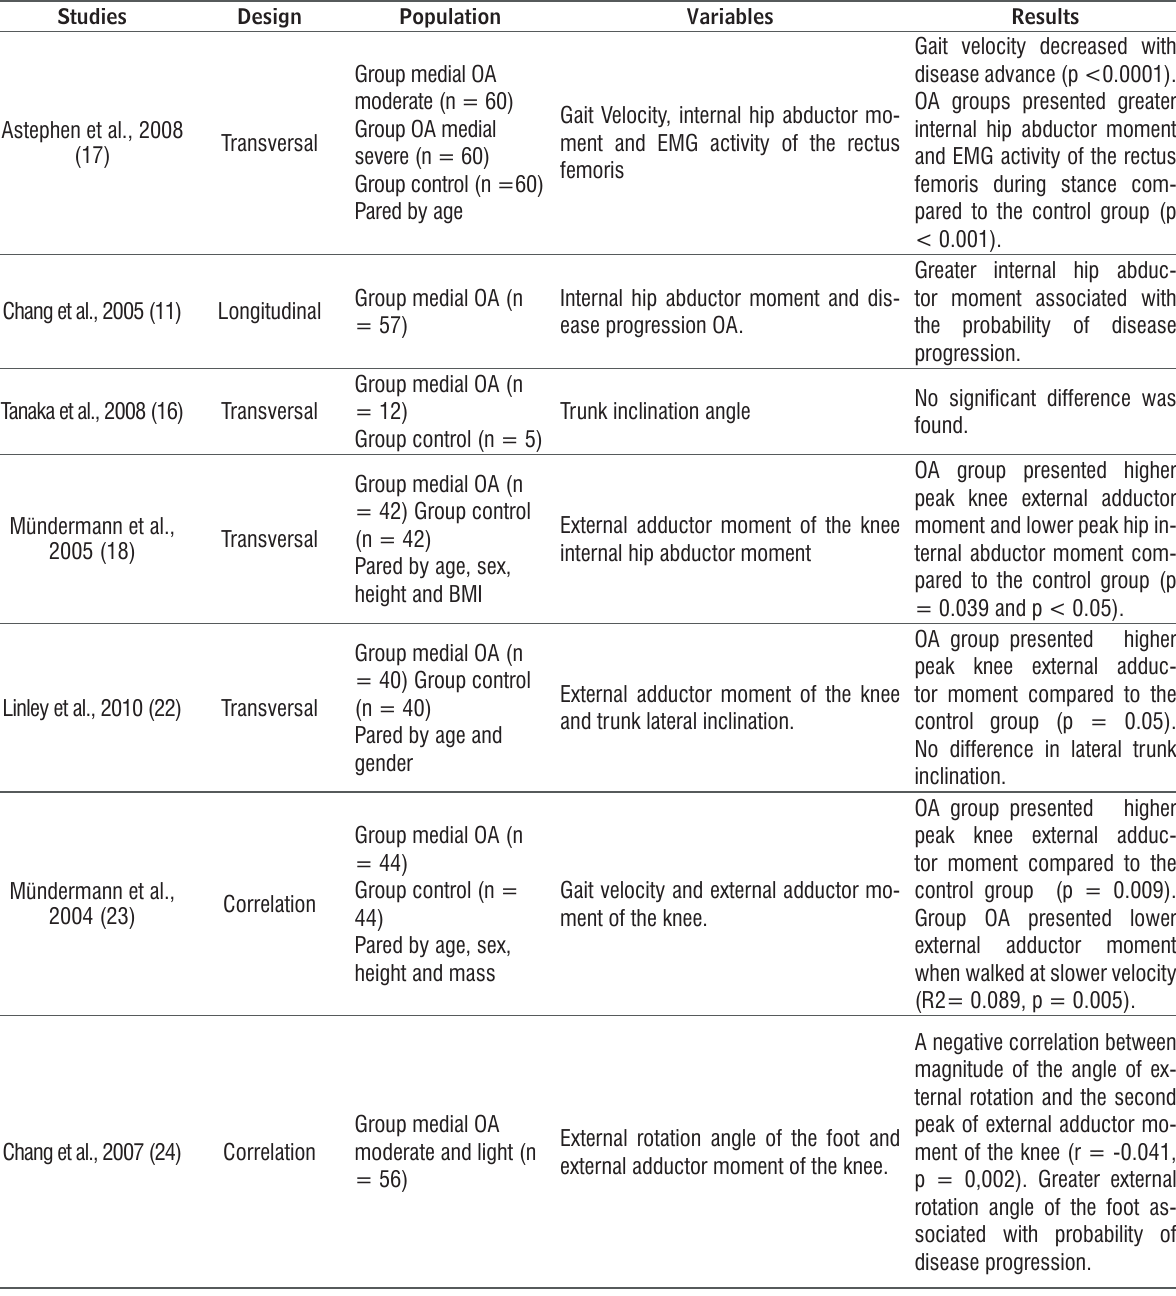
Table 1 - Characteristics of the 23 studies selected for the review Studies Design Population Variables